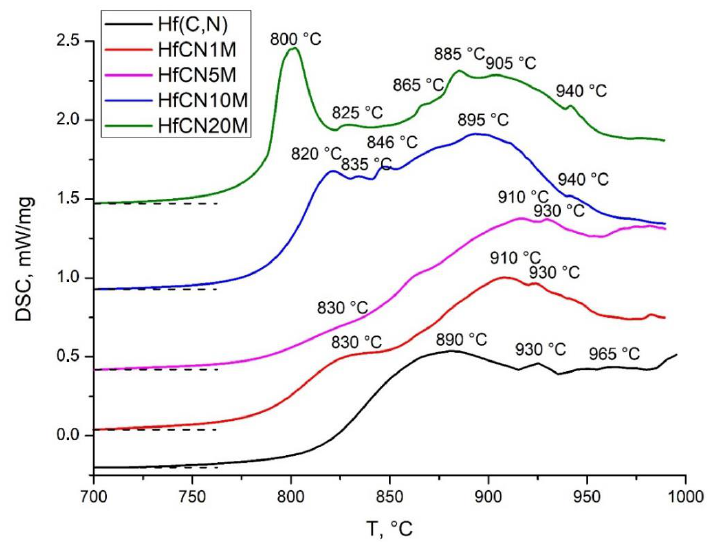
Figure 4. DSC curves during the oxidation of bulk Hf(C,N) and Hf(C,N)-MoSi 2 upon heating to 1000 °C.